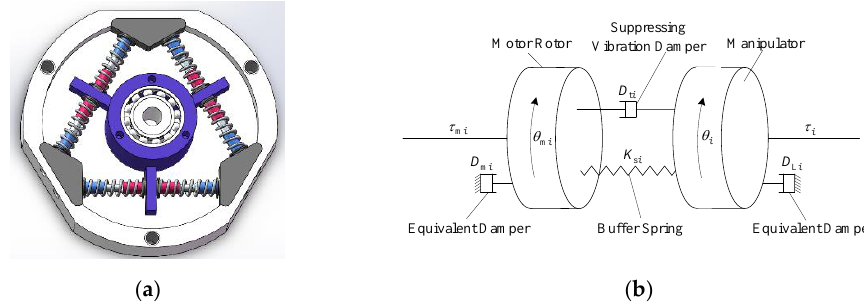
Figure 1. Structure of the SDD. ( a ) 3D structure of SDD, ( b ) Modeling of the SDD.